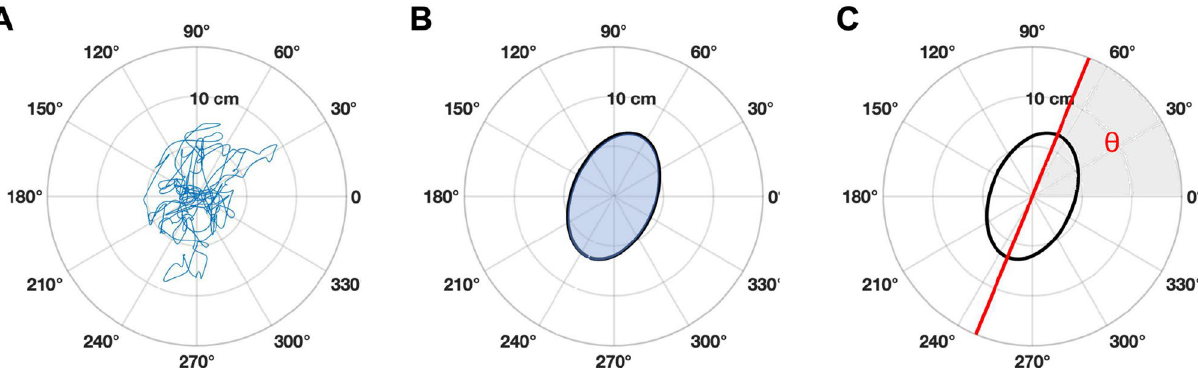
Figure 4. Graphical representation of the dependent variables. In ( A ) the movement of COP is represented by the blue line. The total length of the blue line divided by the time spent to travel this distance provides the speed variable. In ( B ) the movement of the COP can be summarized by the blue shaded area representing the 95% confidence interval ellipse area. The major axis of the ellipse is used to compute the main direction of sway. In ( C ) The red line represents the main direction of sway at an angle θ, symbolized by the grey shaded area. A direction of sway at 90 degrees angle would indicate a pure antero-posterior sway.